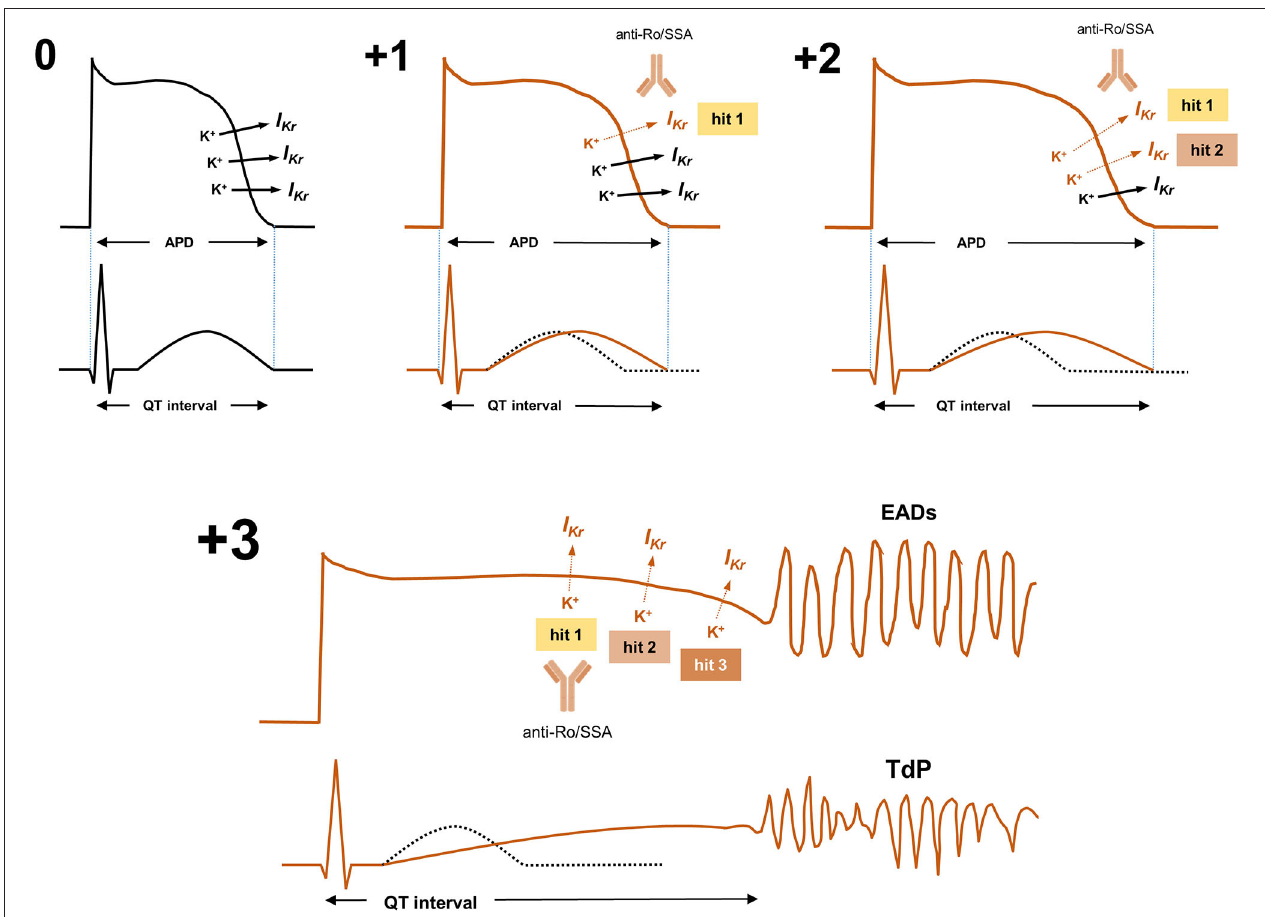
FIGURE 2 | Anti-Ro/SSA-antibodies and the multi-hit theory of long-QT syndrome: given that manifold often-redundant ion channel mechanisms physiologically preserve ventricular APD, hence QTc length (repolarization reserve), many QT-prolonging risk factors (“hits”) need to be concomitantly present in a single patient to induce the marked disruption of ventricular repolarization necessary to the occurrence of life-threatening arrhythmias such as TdP. In the absence of QT-prolonging factors (0), I Kr is preserved, and APD and QTc are normal. In subjects with the sole presence of arrhythmogenic anti-Ro/SSA antibodies partially inhibiting I Kr ( + 1/hit 1), APD/QTc usually slightly/moderately prolongs (or even remains in the normal range, depending on pre-existing genetically-determined repolarization reserve). In these subjects, only the concomitant presence of other genetic or acquired QT-prolonging risk factors further inhibiting I Kr and/or other key ion currents (such as drugs, electrolyte imbalances, etc.: + 2/hit 2, + 3/hit 3, etc.), can induce the marked APD/QTc prolongation critically required for TdP occurrence. I Kr , rapidly activating component of the delayed outward-rectifying K + current; APD, Action potential duration; EADs, early afterdepolarizations; QTc, heart rate-corrected QT-interval; TdP, Torsades de